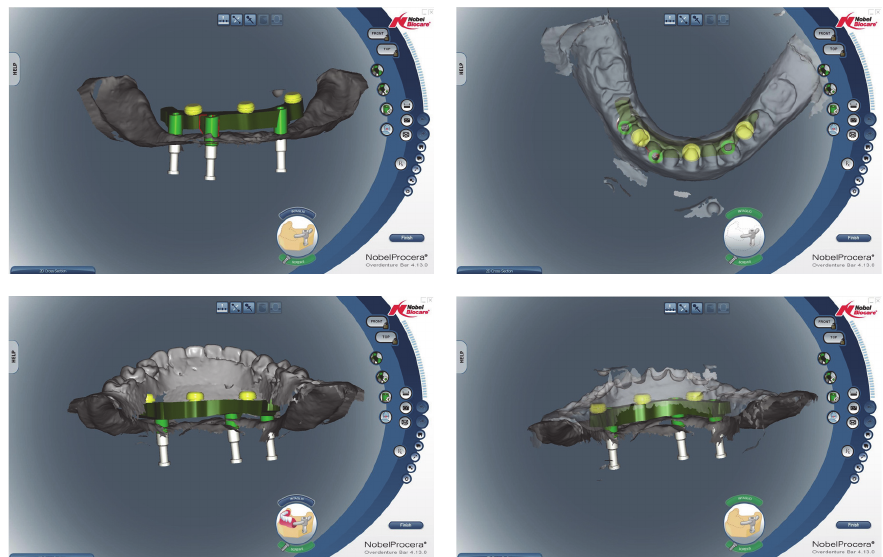
Figure 9: Design of the framework using the Nobel Procera software.